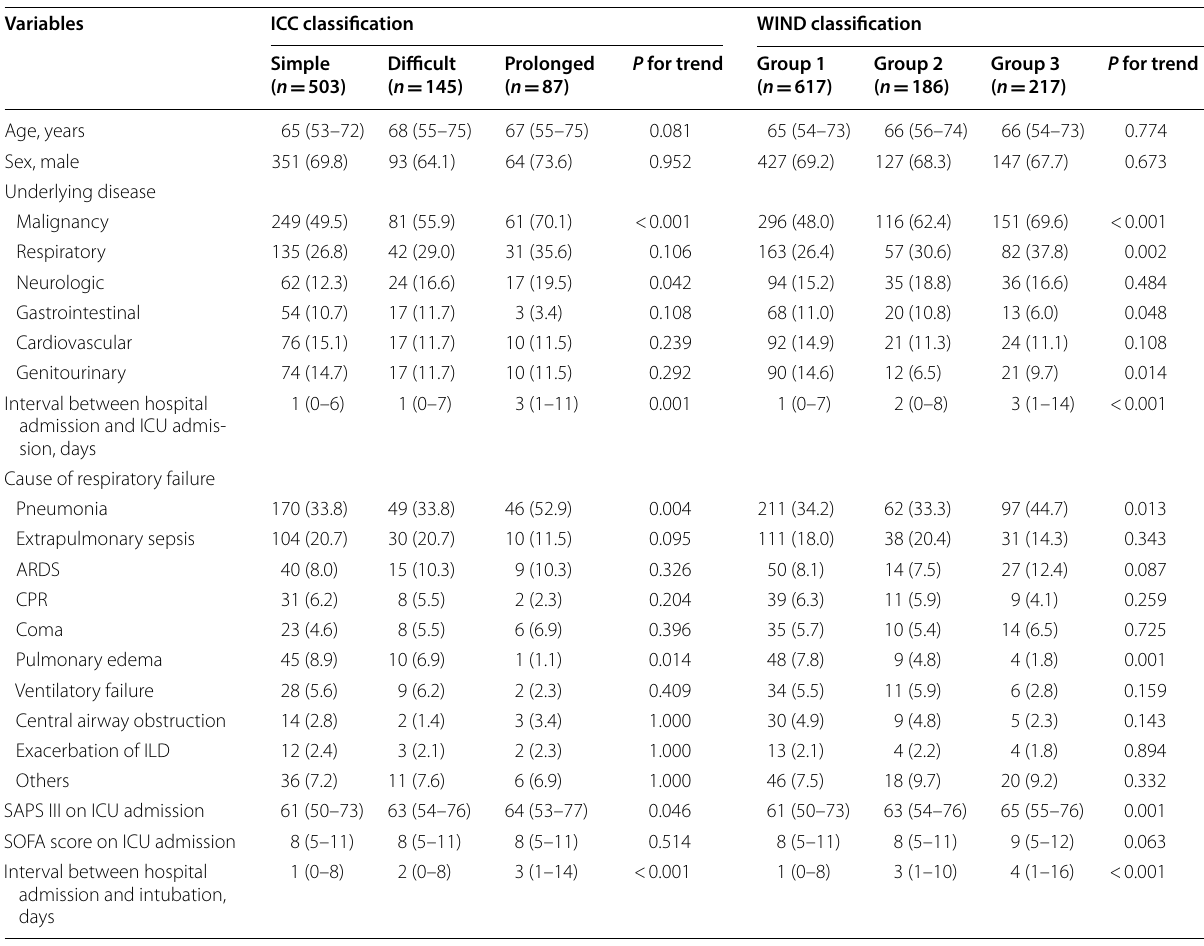
ICC International Consensus Conference, WIND Weaning according to a New Definition, ICU intensive care unit, ARDS acute respiratory distress syndrome, ILD interstitial lung disease, CPR cardiopulmonary resuscitation, SAPS III Simplified Acute Physiology Score III, SOFA Sequential Organ Failure